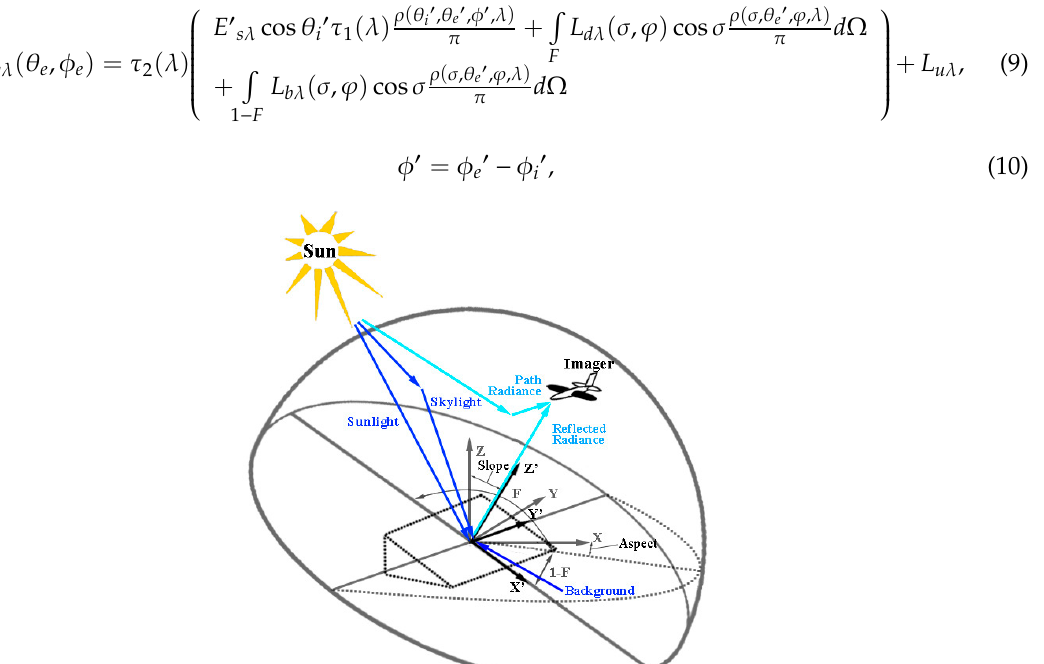
Figure 2. The radiative transfer process [24].